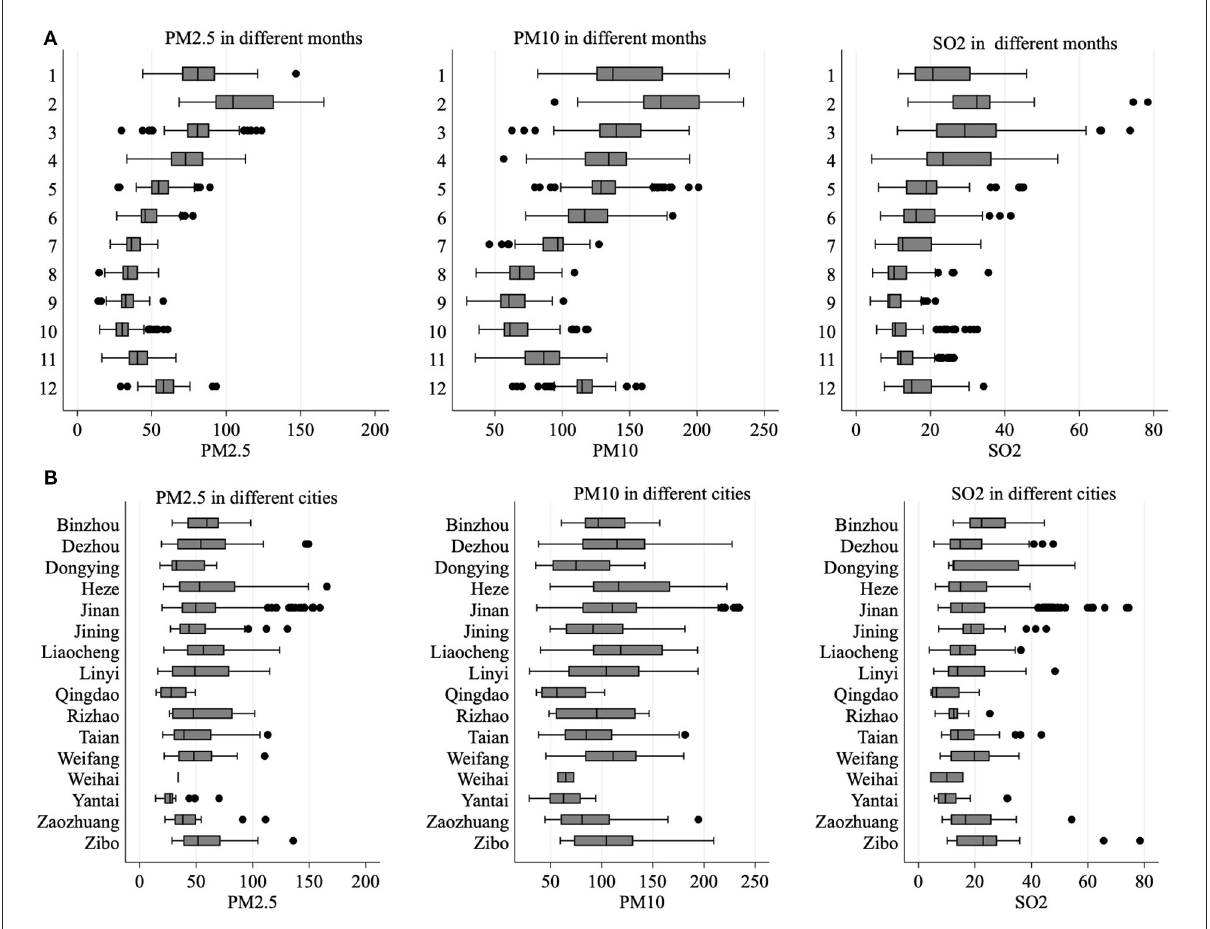
FIGURE1 (A,B) Air pollution in different months and